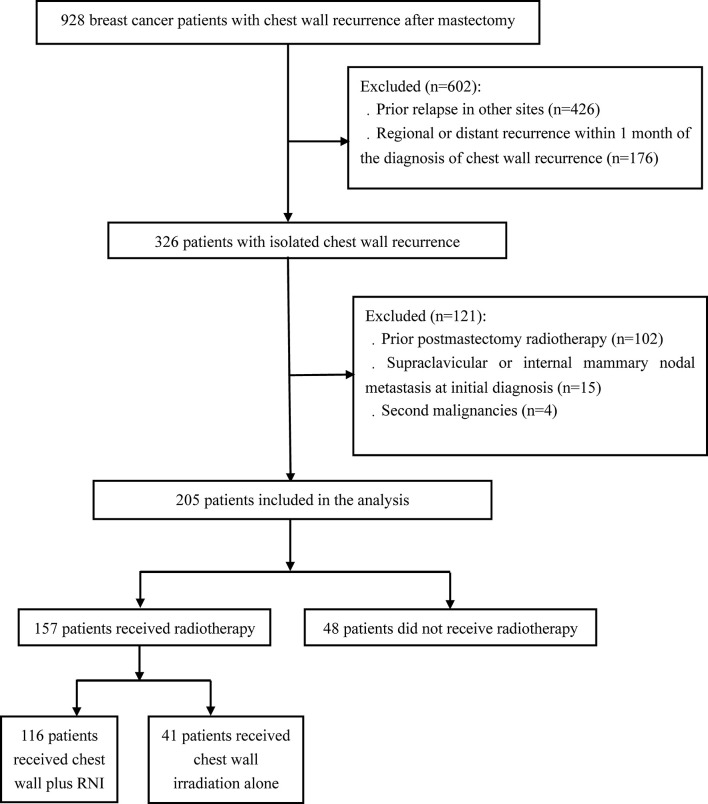
Flow diagram of breast cancer patients included in the study.